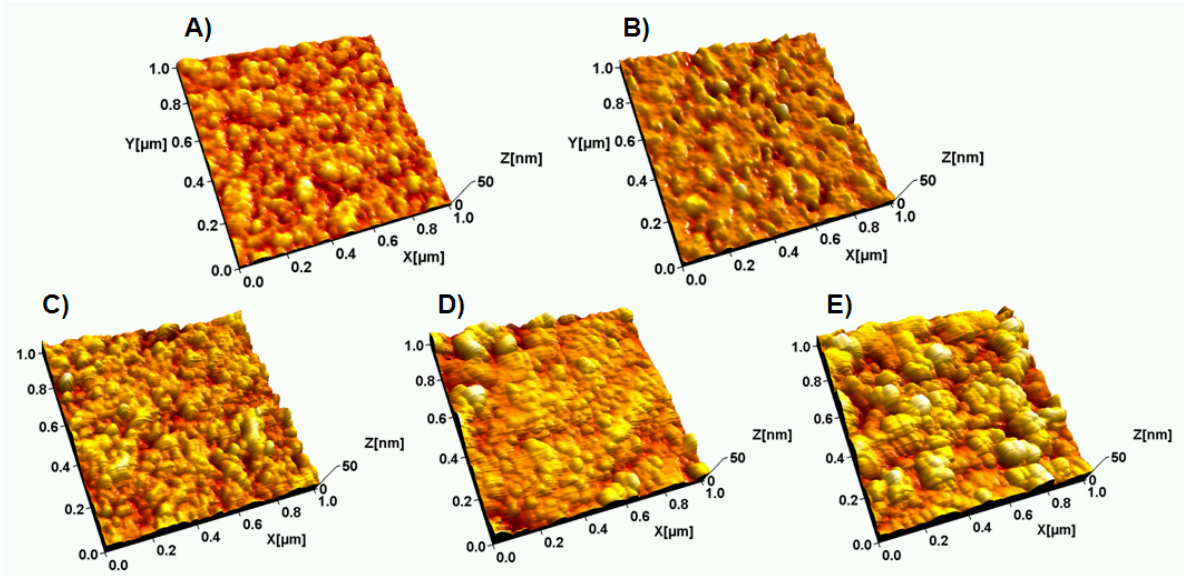
Table 2. Values of selected roughness parameters, including standard deviations,